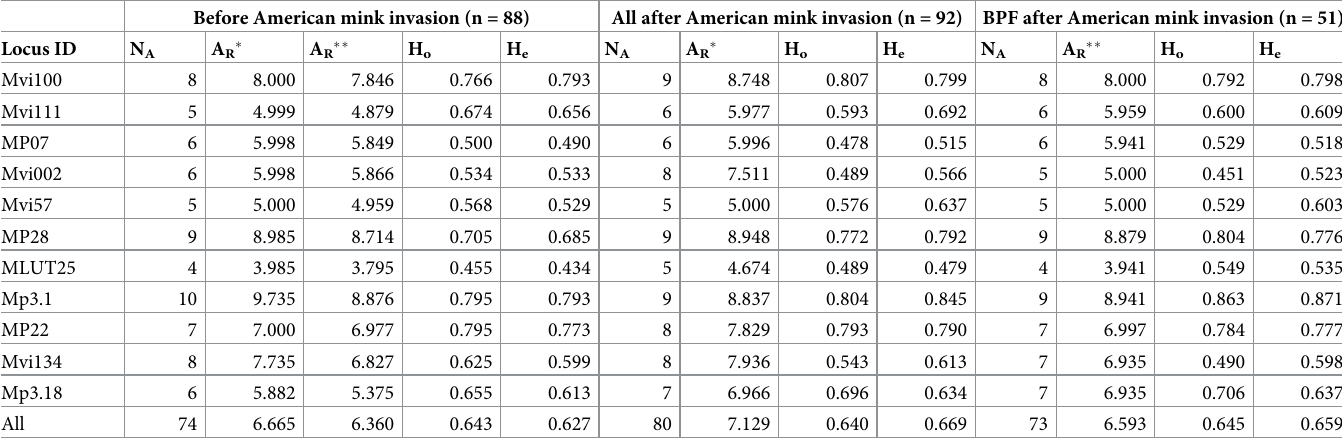
Table 2. Microsatellite genetic diversity in the European polecat population. Before American mink invasion (n =